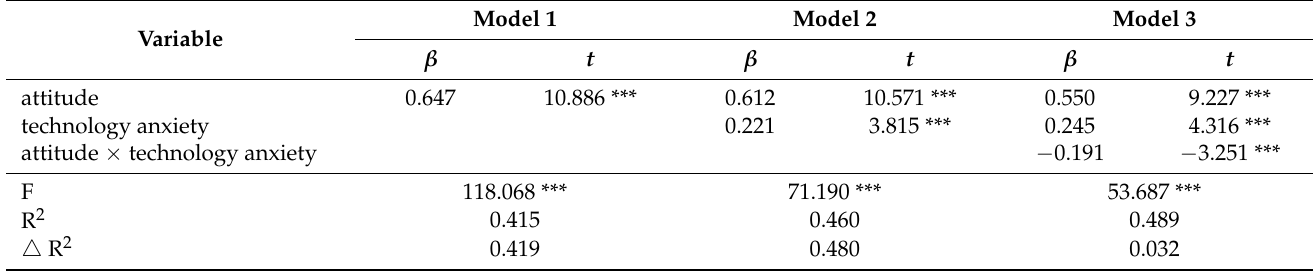
Table 6. Regression analysis of technology anxiety towards attitude and intention to